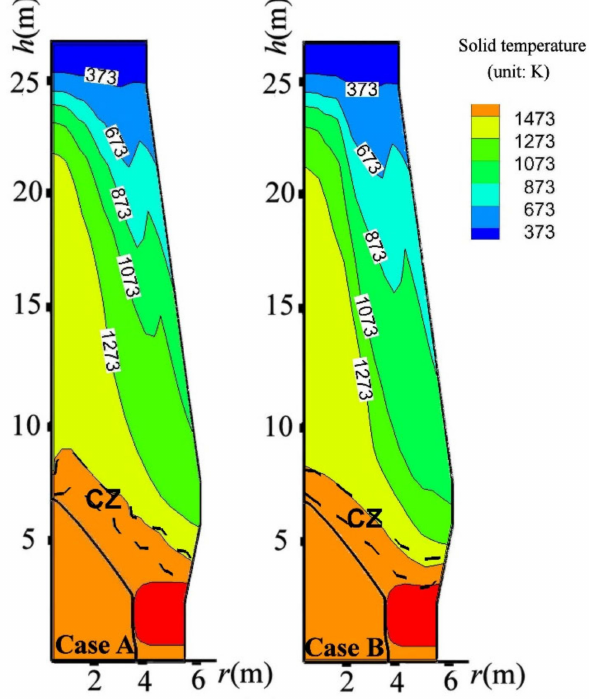
Figure 6. Profiles of solid temperature in cases A and B.